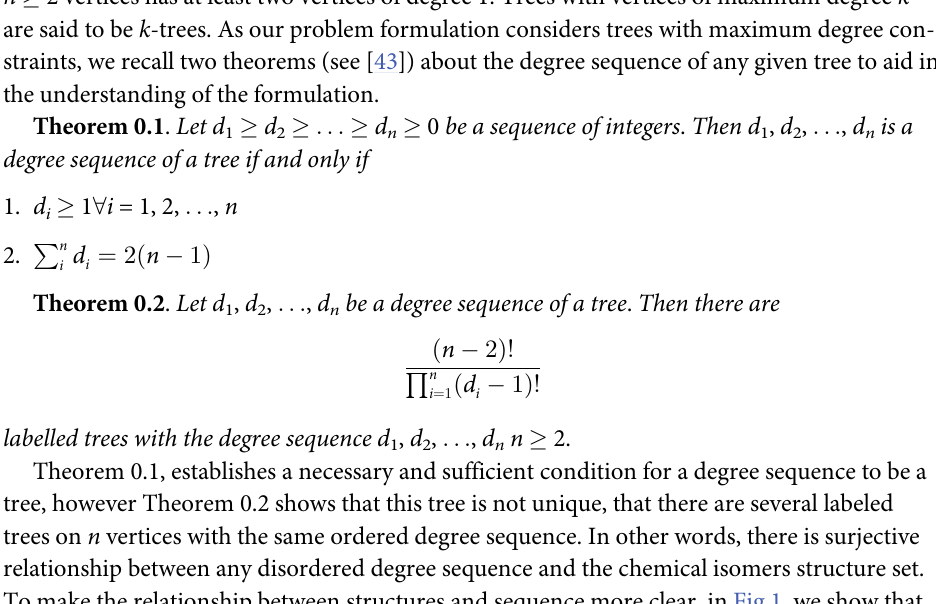
PLOS ONE | https://doi.org/10.1371/journal.pone.0226787 January 15,